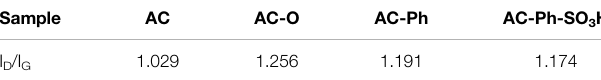
TABLE 4 | Raman spectrum I D /I G of AC, AC-O, AC-Ph and AC-Ph-SO 3